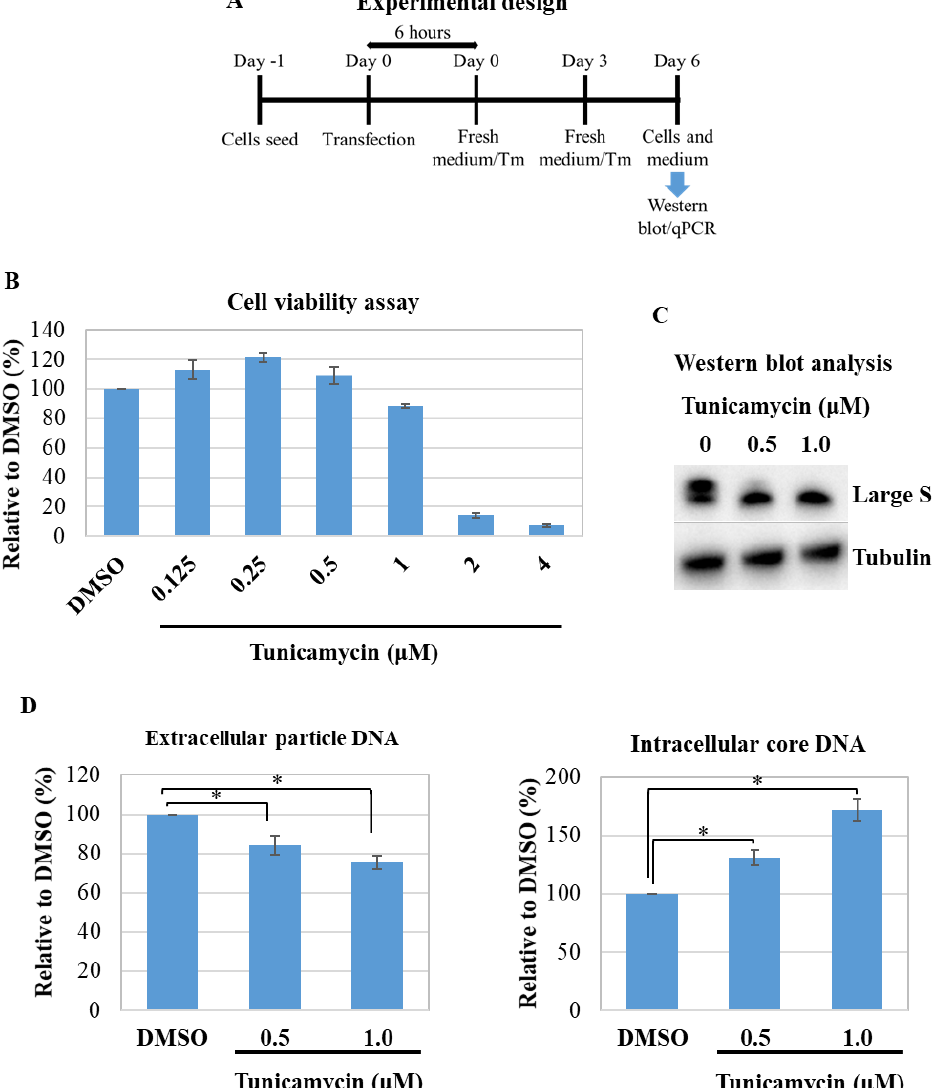
Figure 4. The effect of tunicamycin-induced removal of the glycosylation isoform on HBV replication and virion production. ( A ) Experimental design. The transfected HepG2 cells were treated with the indicated concentration of tunicamycin, and the cells and medium were collected for qPCR and Western blot analysis. ( B ) The cell viability assay. The cells were treated with tunicamycin at the indicated concentration at days 1 and 3 post-seeding, and a viability assay was performed at day 6. ( C ) Western blot analysis from the cell lysates. ( D ) Left: Quantitative real-time PCR (qPCR) of the extracellular virion production. Right: Intracellular core-associated DNA from the transfected and tunicamycin-treated cells. * indicates statistical significance at p < 0.05.